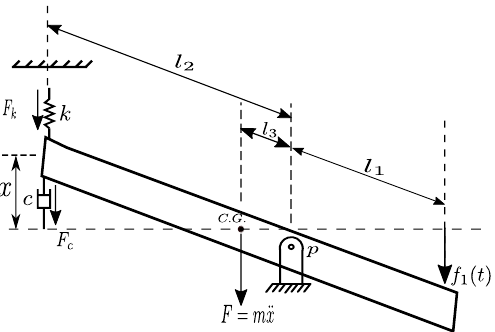
Figure 7. Schematic diagram of the lever device and connecting components like spring and damper. Analyzing Figure 6, one writes: x 1 = l 1 sin ϕ , x 2 = l 2 sin ϕ and x 1